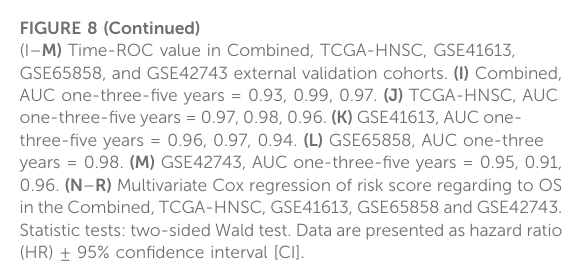
(Figure 7A). We labeled cell types as endothelial cell (Endothelial, gene expression of PLVAP, KDR, PTPRB) and cancer associated fi broblasts cell (CAFs, gene expression of FAP, MMP11, PDGFRB, SFRP2, PDGFRA, ADAMTS2; Figure 7B). In addition to endothelial and cancer associated fi broblasts cell types classi fi ed above, we used “ Single R ” package to identify several other distinct clusters, they were b-cell Naïve, epithelial-cells bladder, epithelial-cells bronchial, monocyte, monocyte:CD14+, monocyte:CD16+, NK cell, CD4 + central memory T cell, CD4 + central effector T cell and tissue- stem-cells:BM_MSC:BMP2 (Figure 7C). To further understand the characteristics for the CAFs, we performed a deconvolution method (Wang et al., 2019) to calculate the bulk tissue proportion of CAFs in TCGA cohort with this single cell RNA sequencing database reference (Supplementary Table S1). Combining clinical data of TCGA-HNSC, we found higher CAFs proportion indicated signi fi cant poorer prognosis for head and neck squamous cell carcinoma (log rank p = 0.0029, Figure 7D). This result validated the high CAFs proportion may be identical to the high CafS as a prognostic indicator in HNSCC.